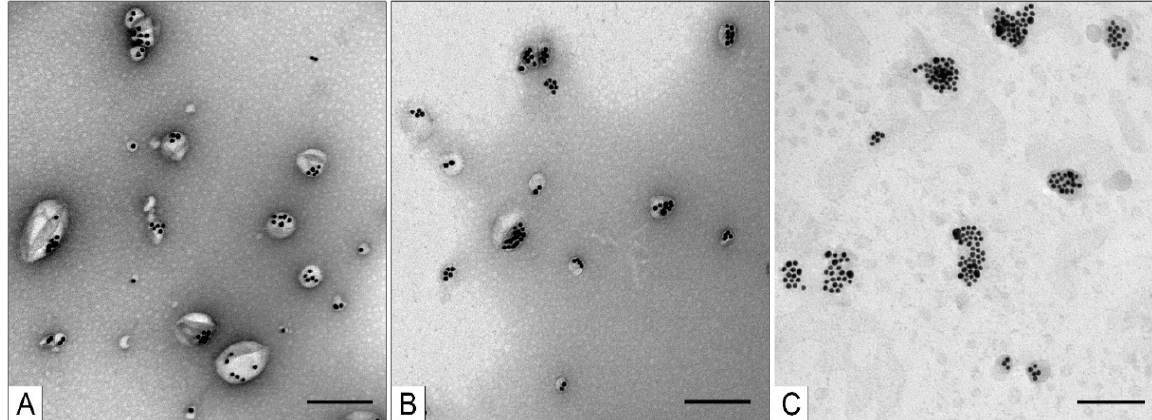
Figure 8. Ultrastructure of the fractions of optimized MLNCs obtained via centrifugation in a 58% sucrose solution for 1 h at 25 °C and 2000× g . ( A ) Upper fraction, ( B ) middle fraction, and ( C ) bottom fraction. The scale bars correspond to 200 nm. Negative staining with a 0.5% uranyl acetate solution followed by TEM.